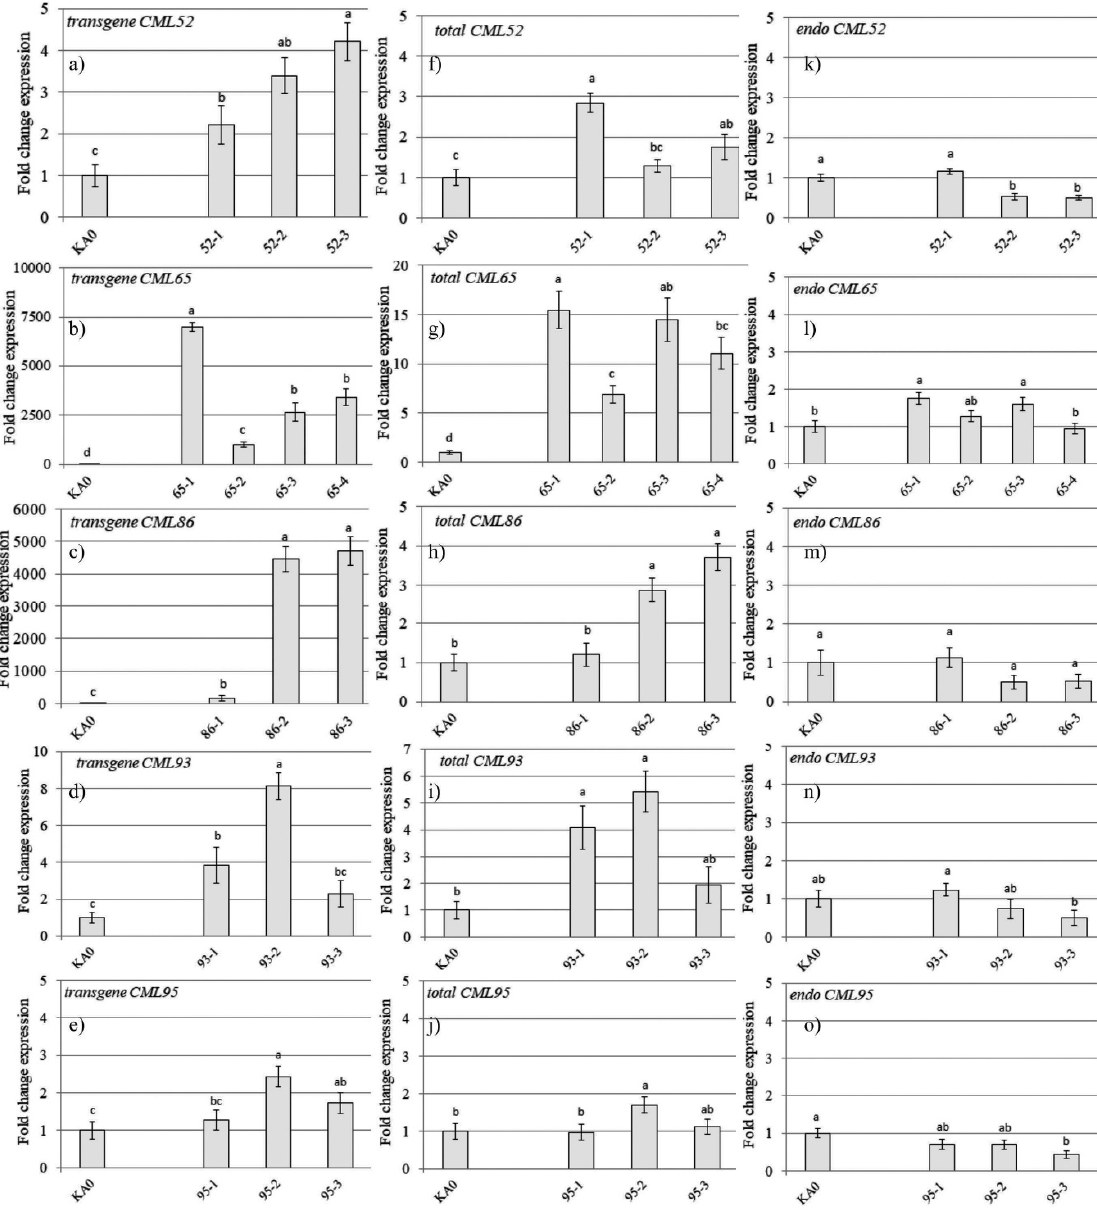
Figure 1. Quantification of the transgene ( a – e ), total ( f – j ), and endogenous ( k – o ) VaCML gene expression in the transgenic cells of Vitis amurensis performed by quantitative RT-PCR. RNA was extracted from control V. amurensis cell line transformed with the empty vector harboring only npt II selective marker (KA0) and V. amurensis cell lines transformed with the VaCML52 ( a , f , k , VaCML52 -1, -2, and -3), VaCML65 ( b , g , l , VaCML65 -1, -2, -3, and -4), VaCML86 ( c , h , m , VaCML86 -1, -2, and -3), VaCML93 ( d , i , n , VaCML93 -1, -2, and -3), and VaCML95 ( e , j , o , VaCML95 -1, -2, -3, and -4) genes. The data are presented as mean ± SE (two independent experiments with eight technical replicates). Means on each figure followed by the same letter were not different using one-way analysis of variance (ANOVA), followed by the Tukey HSD multiple comparison test.